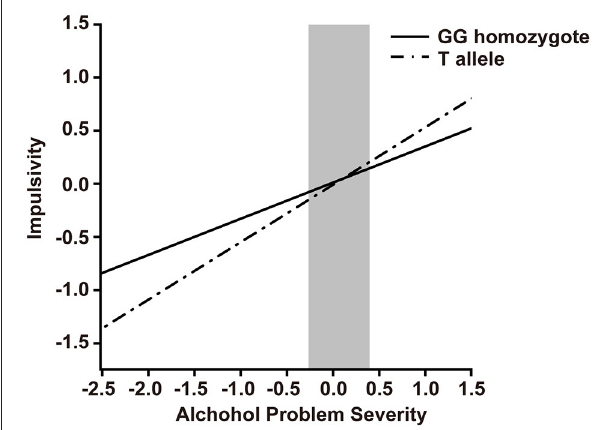
FIGURE 1 | RoS test on Impulsivity from Alcohol Problem Severity in rs1344706 allelic groups. Impulsivity is measured by Barratt Impulsiveness Scale (BIS), alcohol problem severity is measured by Michigan Alcoholism Screening Test (MAST). Gray shaded area represents 95% CI of the crossover point C of the interaction on the alcohol dependence axis. 95% CI of C ranged from − 0.26 to 0.39. Simple slope at GG homozygote = 0.34, t = 10.75, p < 0.0010. Simple slope at T allele = 0.54, t = 11.51, p < 0.0010.